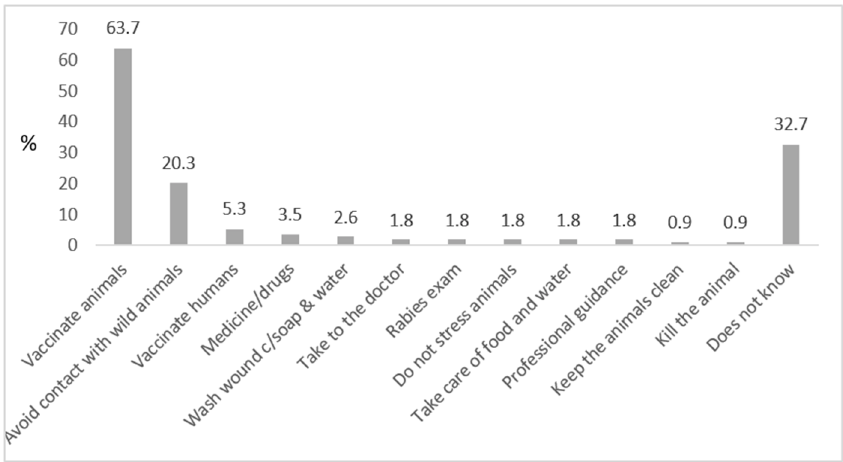
Figure 5. Knowledge on prevention of rabies, as reported by respondents (vaccination of animals and avoiding contact with wild animals were considered as correct answers). Killing the animal was considered an incorrect answer; after an act of aggression, domestic animals (esp. dogs) should be observed for a defined period at a safe place (without the possibility of contact to other animals or to humans).